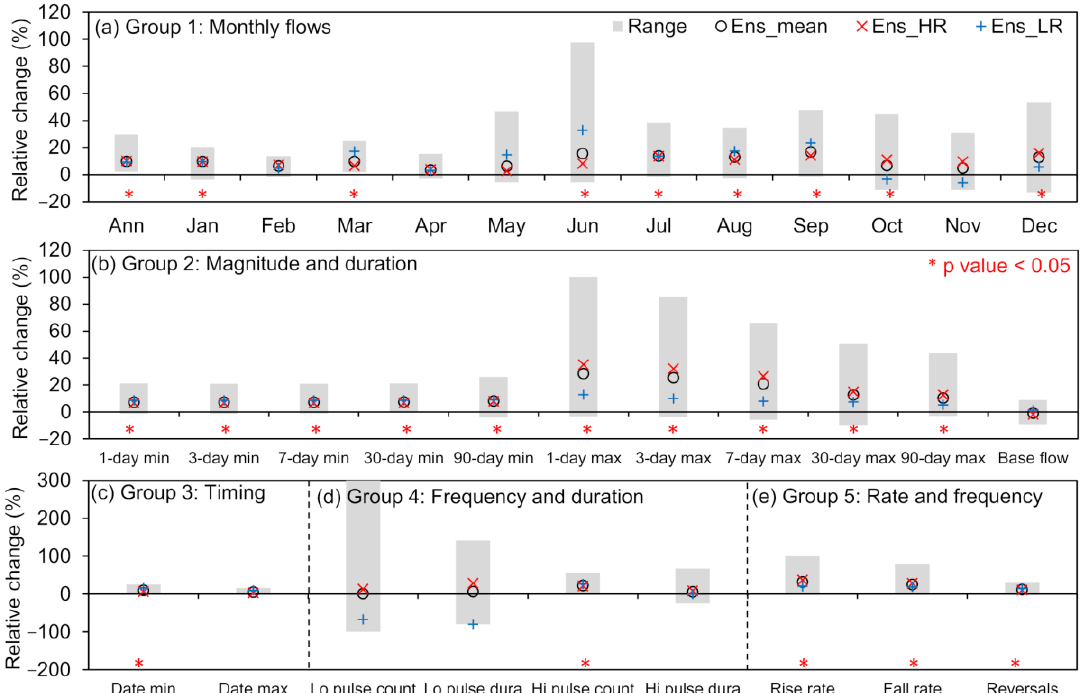
Figure 6. Projected changes in hydrological extremes as indicated by 32 IHA parameters of ( a ) monthly flows, ( b ) magnitude and duration, ( c ) timing, ( d ) frequency and duration and ( e ) rate and frequency between 1985–2014 and 2021–2050 at the Jambatan Guillermard station.